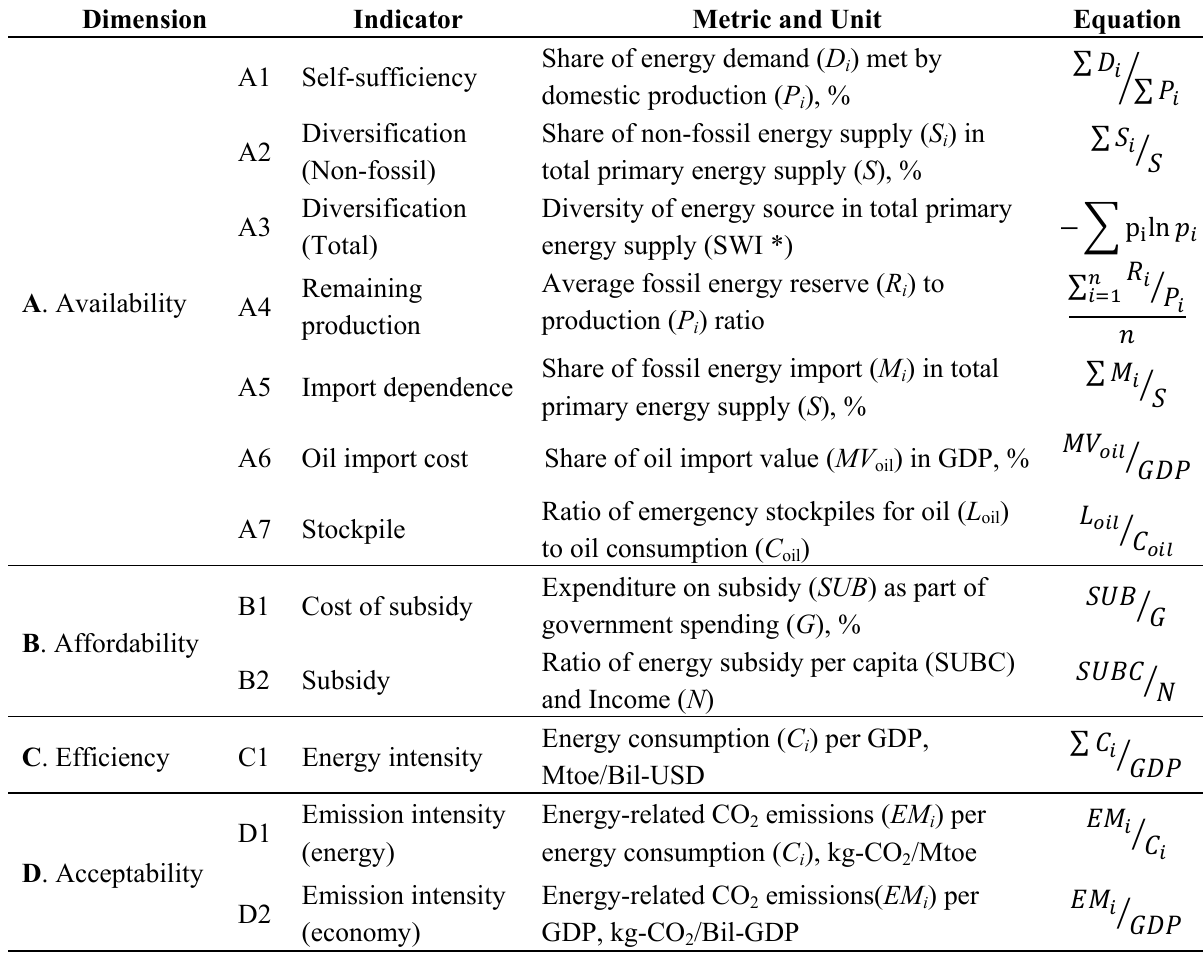
Table 2. Energy security dimensions and indicators in this